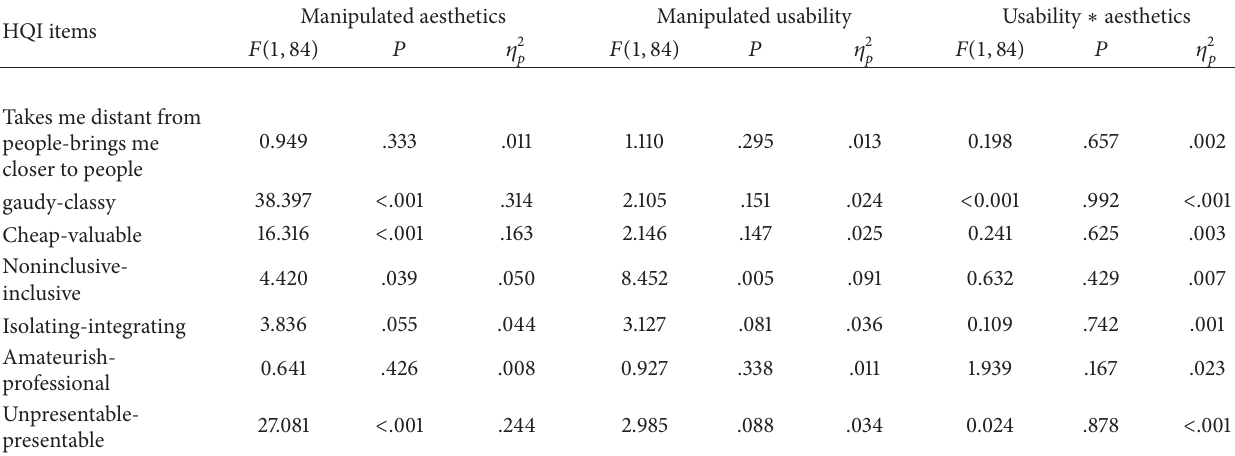
Table 1: Effects of manipulated beauty and manipulated usability on HQI items.